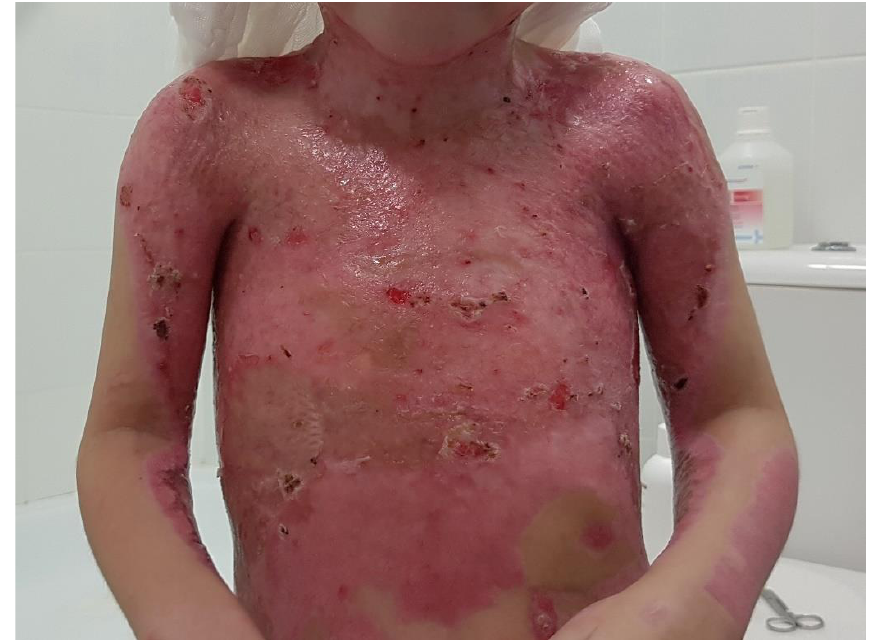
Figure 4. Final result (on discharge from hospital).